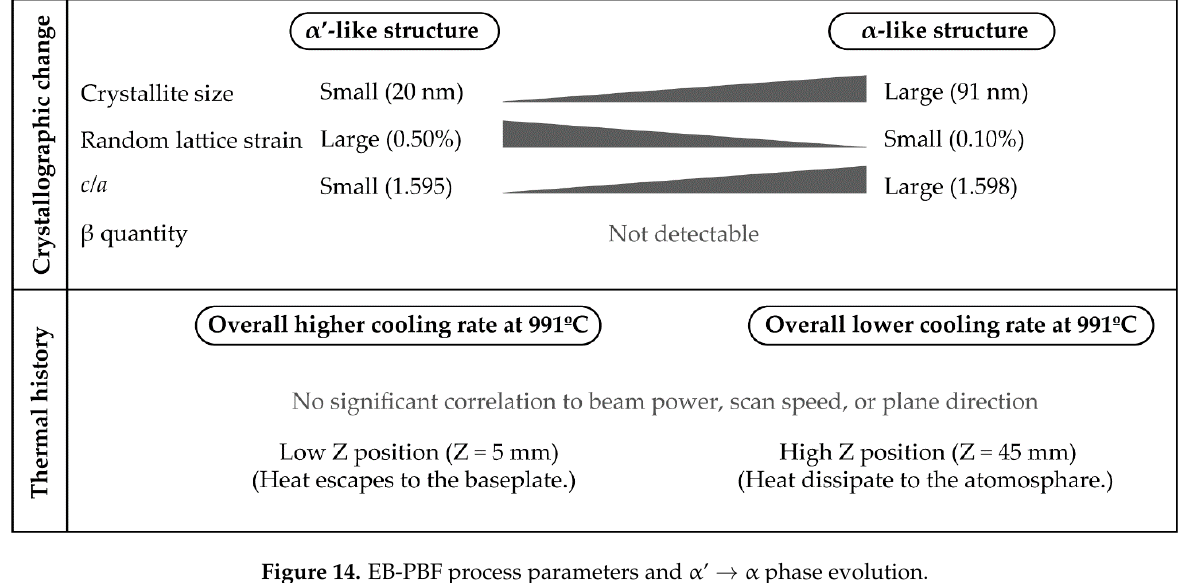
Figure 13. L-PBF process parameters and α ’ → α + β phase evolution.